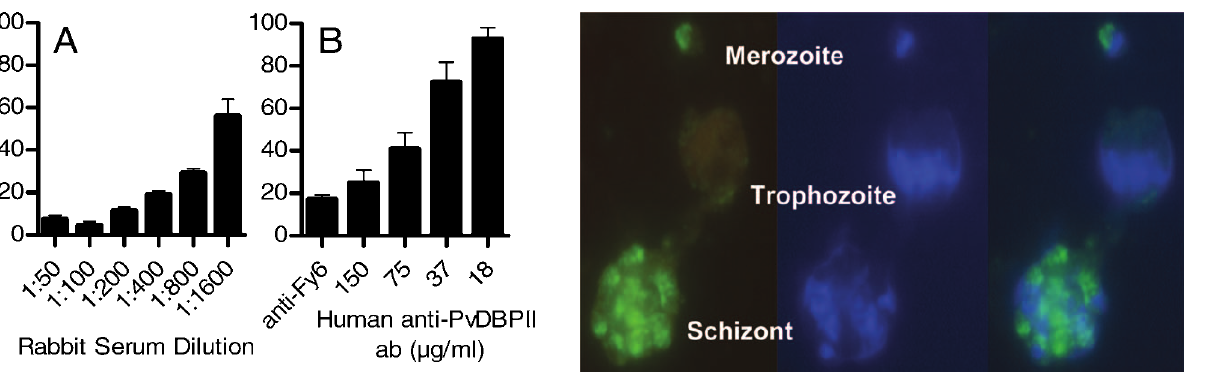
Figure 3. Rabbit Anti-PvDBPII Ab Staining of P. vivax Merozoites in Infected Human Erythrocytes Rabbit anti-PvDBPII serum binding to fixed P. vivax merozoite, trophozoite, and schizont (uninfected cells not shown) was confirmed by immunofluorescence microscopy. Parasites were enriched by Percoll gradient centrifugation from a Thai patient infected with P. vivax . In the left panel, PvDBPII is stained green by a 1:10 dilution of rabbit anti- PvDBPII serum, followed by FITC-conjugated goat anti-rabbit antibody. In the middle panel, DNA is stained blue by Hoechst. The right panel shows the overlay of the left and middle micrographs. Additionally, the antibody concentrated anterior to the nucleus towards the apical end of the merozoite where PvDBPII is known to be expressed in the micronemes [18].